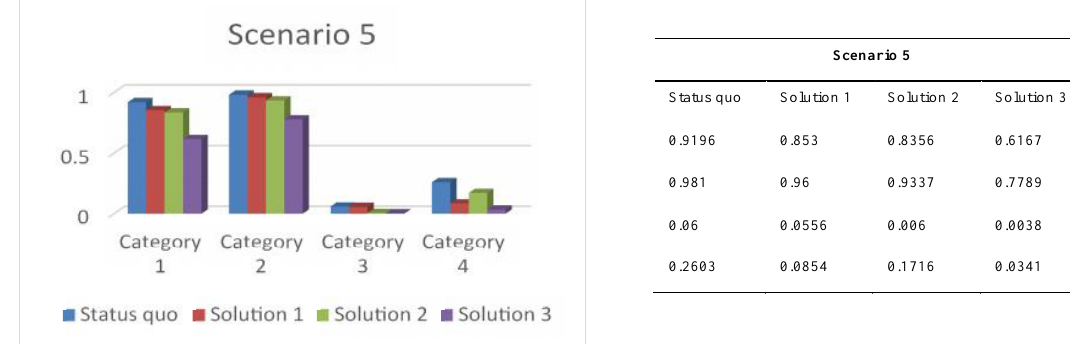
Fig. 11: The results of accident probabilities after the adoption of the proposed